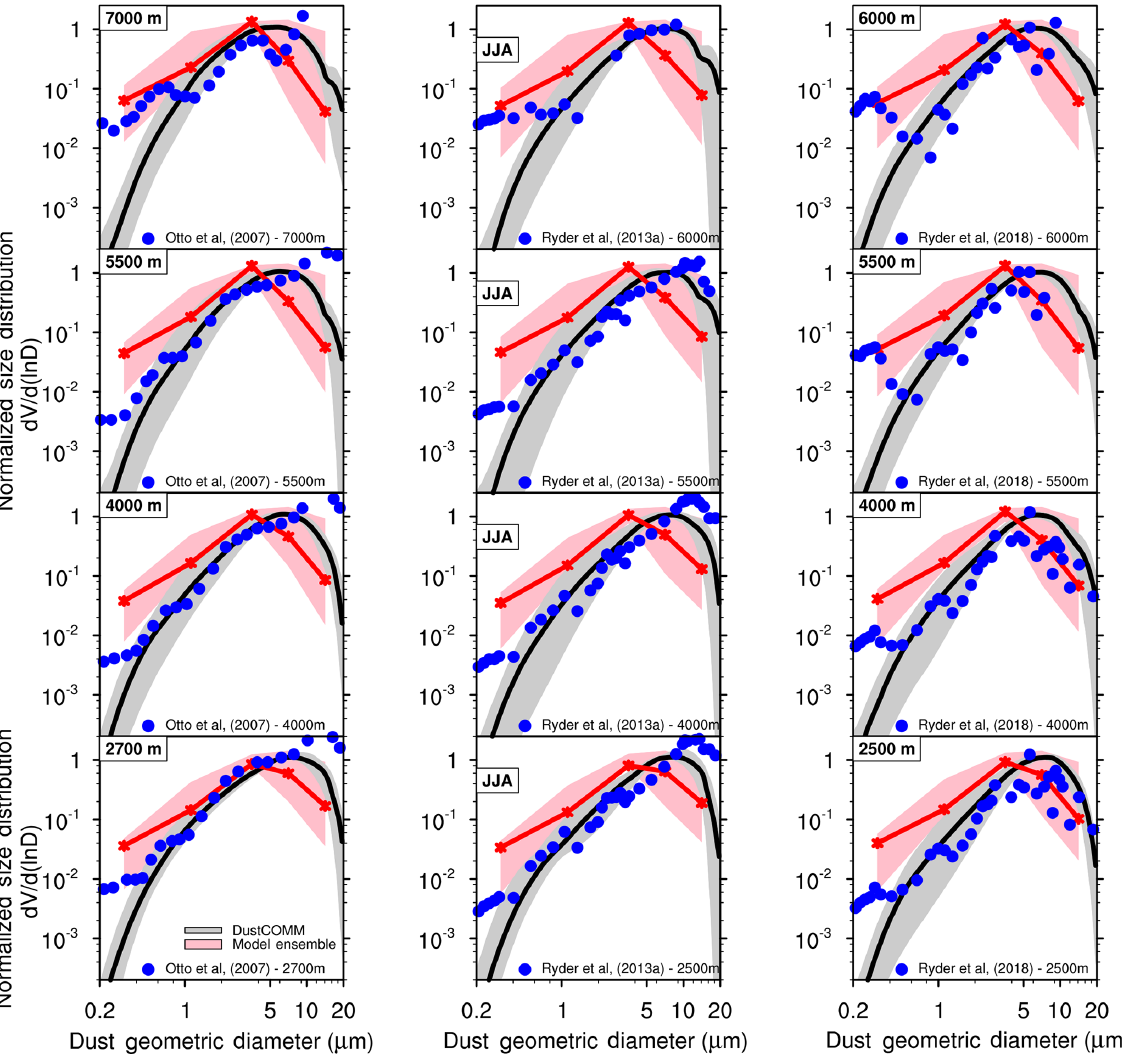
Figure 3. Same as Fig. 2 above but as a function of height, which increases from bottom to top. The measurements plotted in the left panels are from Otto et al. (2007) taken during the ACE-2 campaign (June/July 1997) in the vicinity of the Canary Islands; the measurements plotted in the middle panels are from Ryder et al. (2013a) taken during the Fennec project (June 2011) near the Canary Islands; and the measurements plotted in the right panels are from Ryder et al. (2018) taken during the AER-D campaign in August 2015 near Cabo